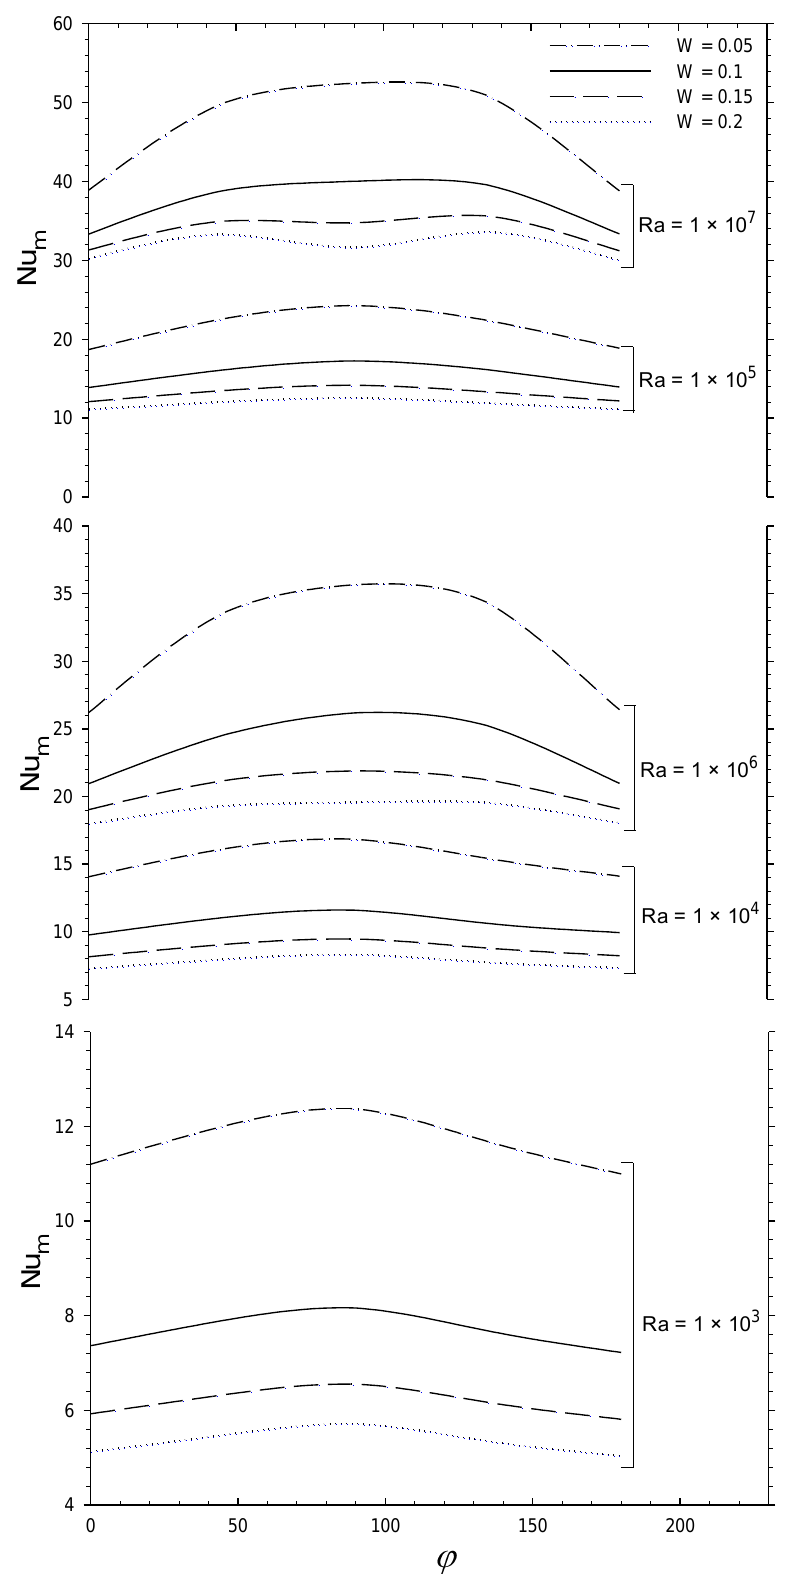
Figure 11. Variations in the mean Nusselt number for a slender cuboid with inclination ϕ for different Ra and W .